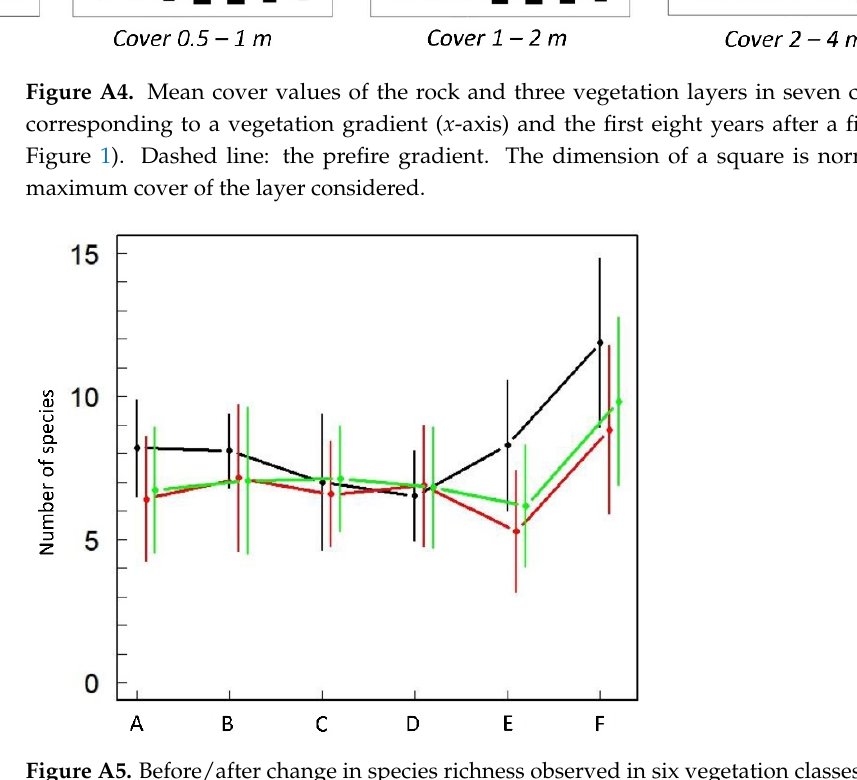
Figure A6. Postfire trajectories of some study stations in the plane defined by the two first axes of correspondence analysis of the bird matrix. Each small black square corresponds to an annual sur- vey (the maximum monitoring duration is specified). Large black squares: prefire surveys, red tri- angles: first postfire surveys, green diamonds: end of the chronosequences (the number of years is indicated). ( a , b ): low maquis, ( c ): Erica arborea and E. scoparia maquis, ( d ): holm oak stand, ( e ): cork oak stand, ( f ): repeated surveys in an unburned cork oak stand (blue) and a holm oak stand (green). The large black square in ( d ) corresponds to a nearby unburned control. References 1.